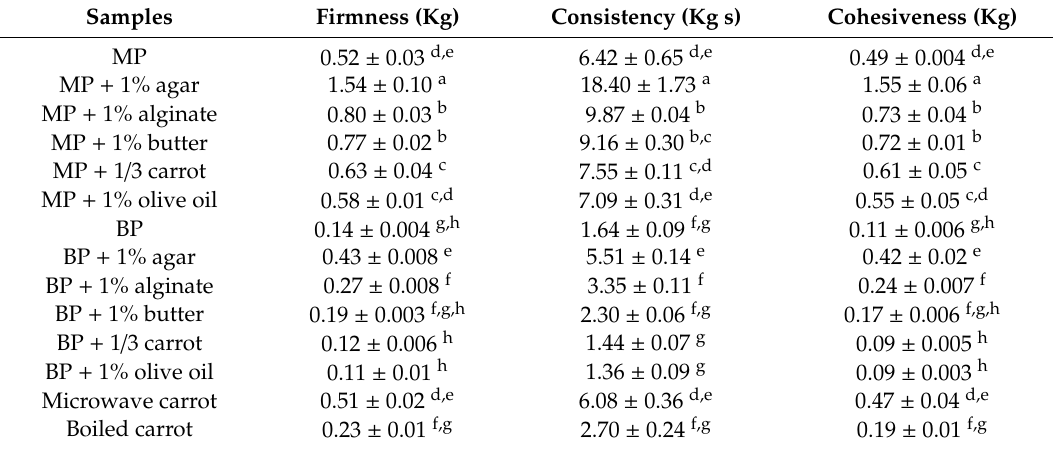
Table 1. Mechanical characteristics values of firmness (Kg), consistency (Kg · s), and cohesiveness (Kg) of potato tubers with di ff erent types of food additives and after being exposed to two methods of cooking microwaving (MP) and boiling